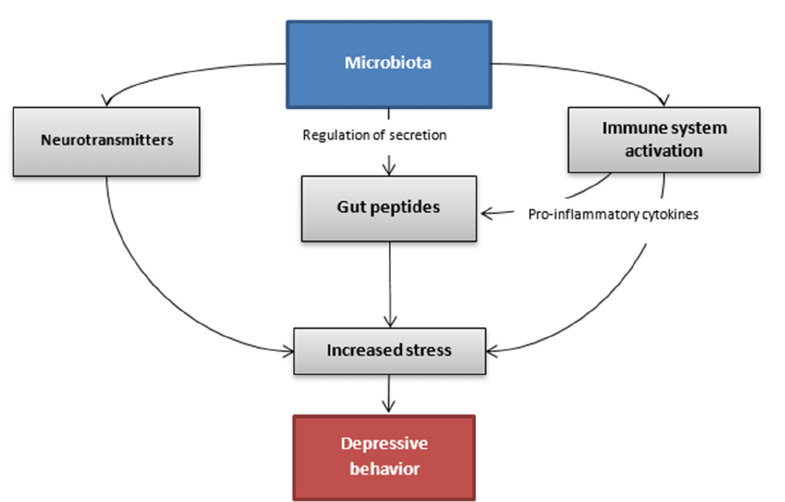
Figure 2. Hypothetic communication pathways between the gut microbiota and the brain in the depressive state.